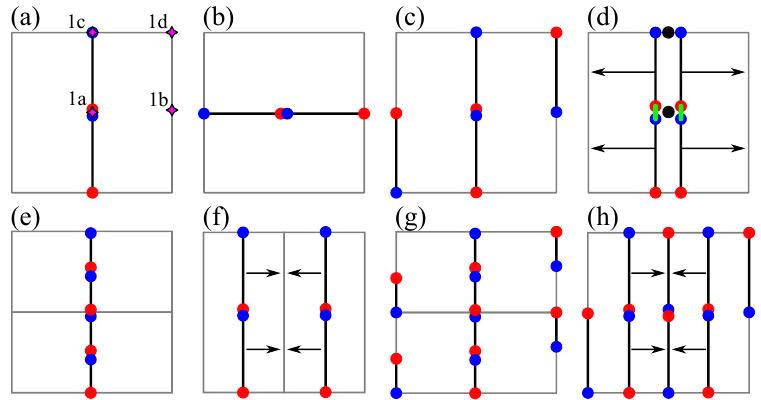
Figure C.4: Panels (a), (b) and (c) repeat for convenience the generating set of valid 1-cell decorations for two dimensional twofold rotation symmetric lattices with topological invariants as in Fig. 6 in the main text. In panel (a) we included the labels of the maximal Wyckoff positions at the twofold rotation axes denoted by the violet stars. The decorations (a), (b), (c) have the topological